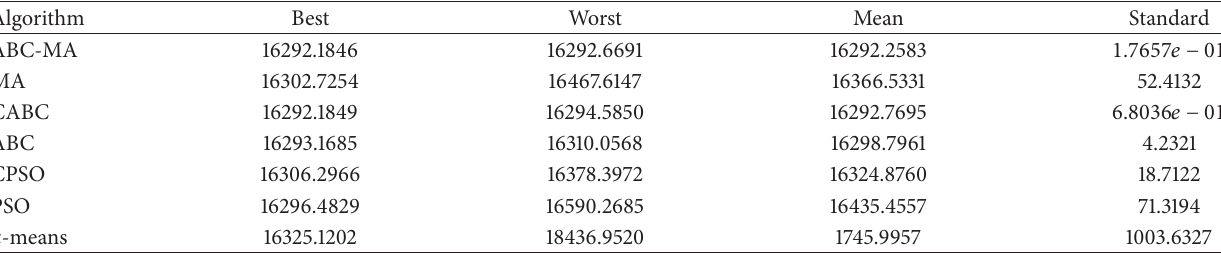
Table 5: Results obtained by the algorithms for 20 different runs on wine